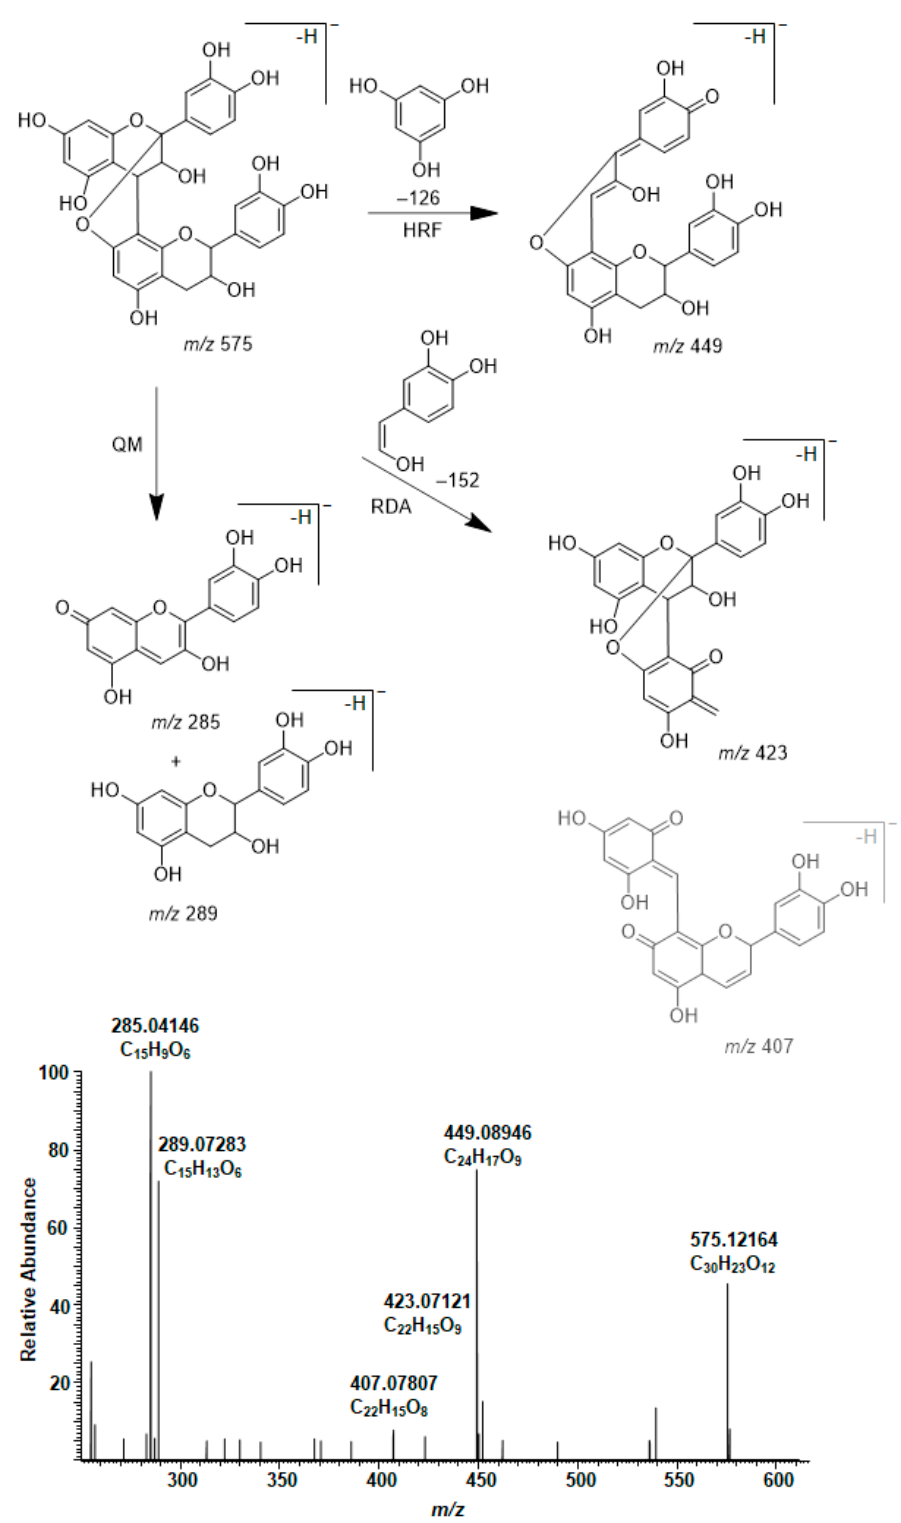
Figure 4. Characteristic fragmentation pathway and the MS/MS of A-type procyanidin dimer in the leaf extract of Aglaonema crispum . The mechanisms are heterocyclic ring fission (HRF), retro-Diels–Alder (RDA) fragmentation and quinone methide (QM) cleavage [26,34]. The ion at m / z 407 is a tentative suggestion for the RDA fragmentation and the sequential water elimination of the extension unit.